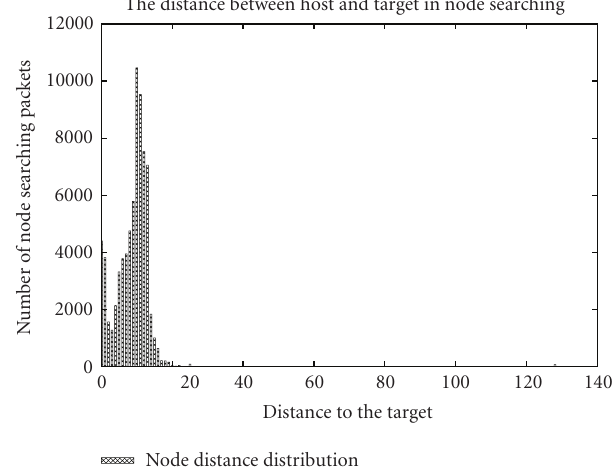
Figure 4: The distance distribution of nodes